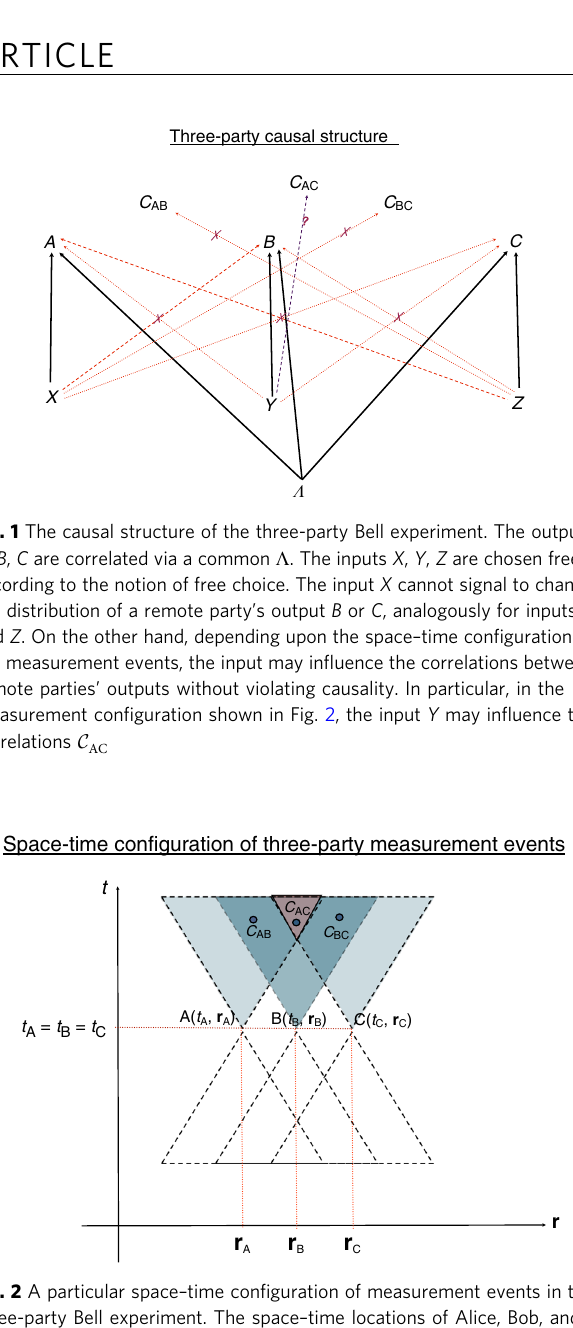
NATURE COMMUNICATIONS| (2019) 10:1701